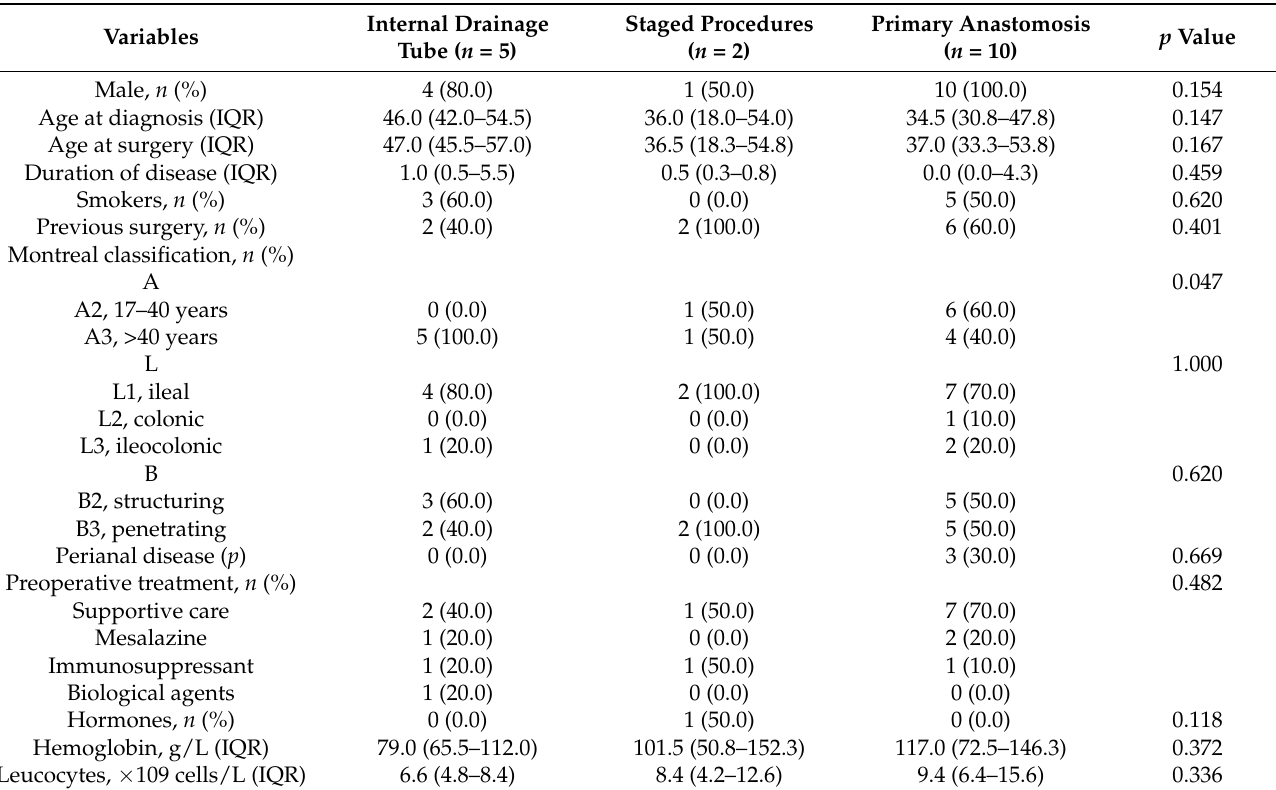
Table 1. Baseline characteristics of emergency